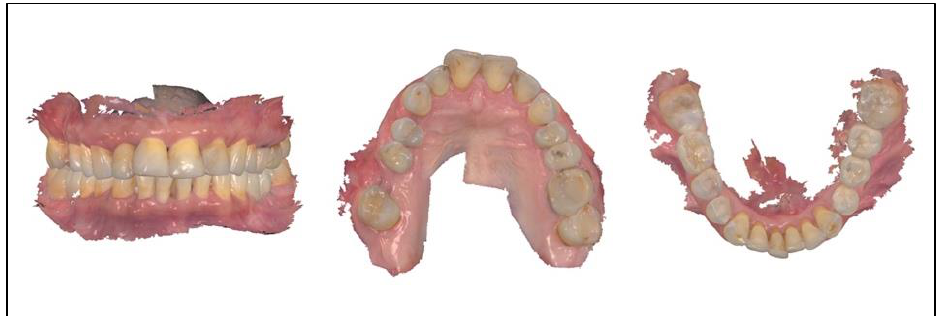
Figure 12. Initial panoramic radiograph of the patient in case number 2.